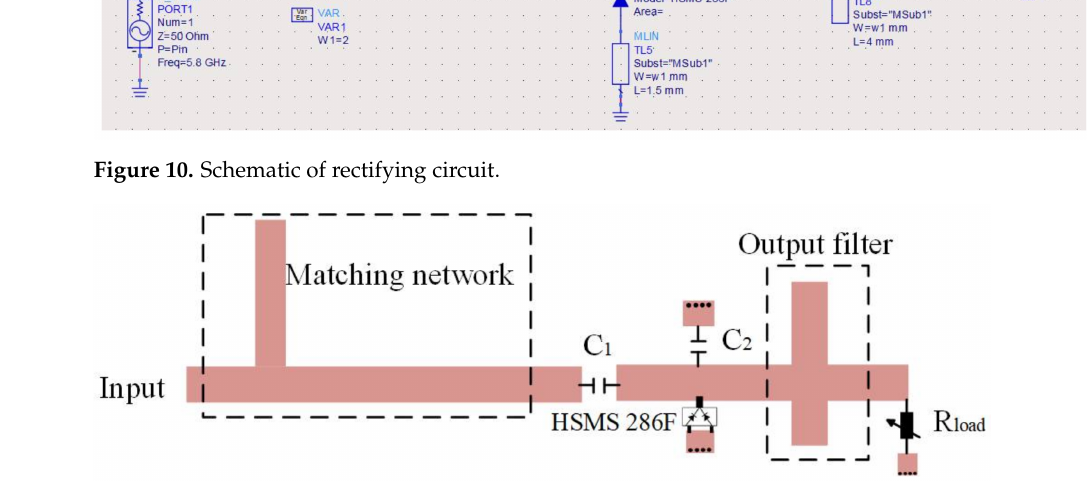
Figure 11. Layout of the fabricated rectifying